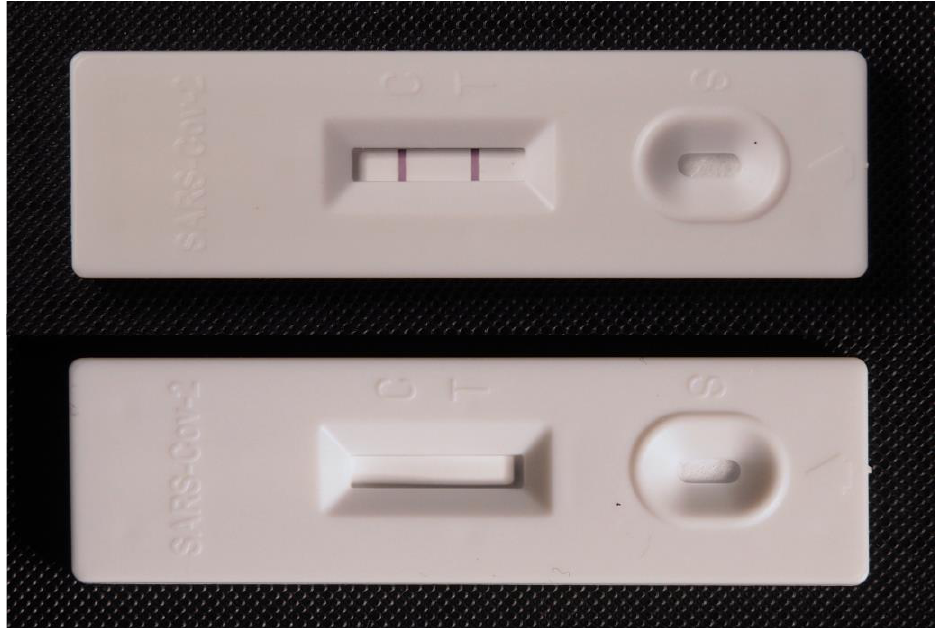
Figure 1. Example of a commercially available antigen lateral flow test for the diagnosis of COVID-19. A test with formed test and control lines is depicted in the upper photograph. An un- used test is shown in the bottom